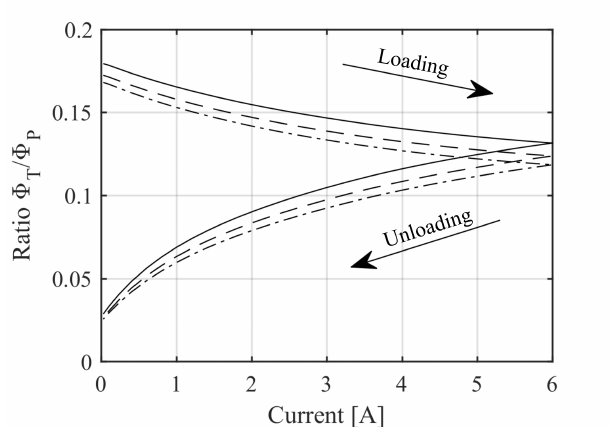
Figure 10. Ratio between the magnetic flux through the top face of one polar expansion of the electromagnet and the flux flowing through the polar area at 0.55 mm (solid), 0.50 mm (dashed) and 0.45 mm (dash-dotted) air gap for the system based on the FeCrCo 48/5 journal. Loading and unloading curves are related to the current increase from 0 to 6 A and the current decrease from 6 to 0 A,